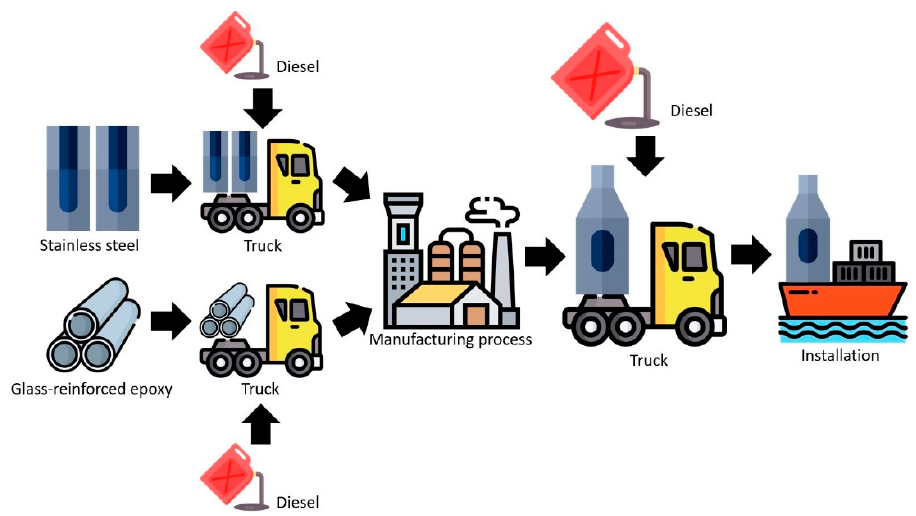
Figure 4. LCA model for construction phase of scrubber system through GaBi software.